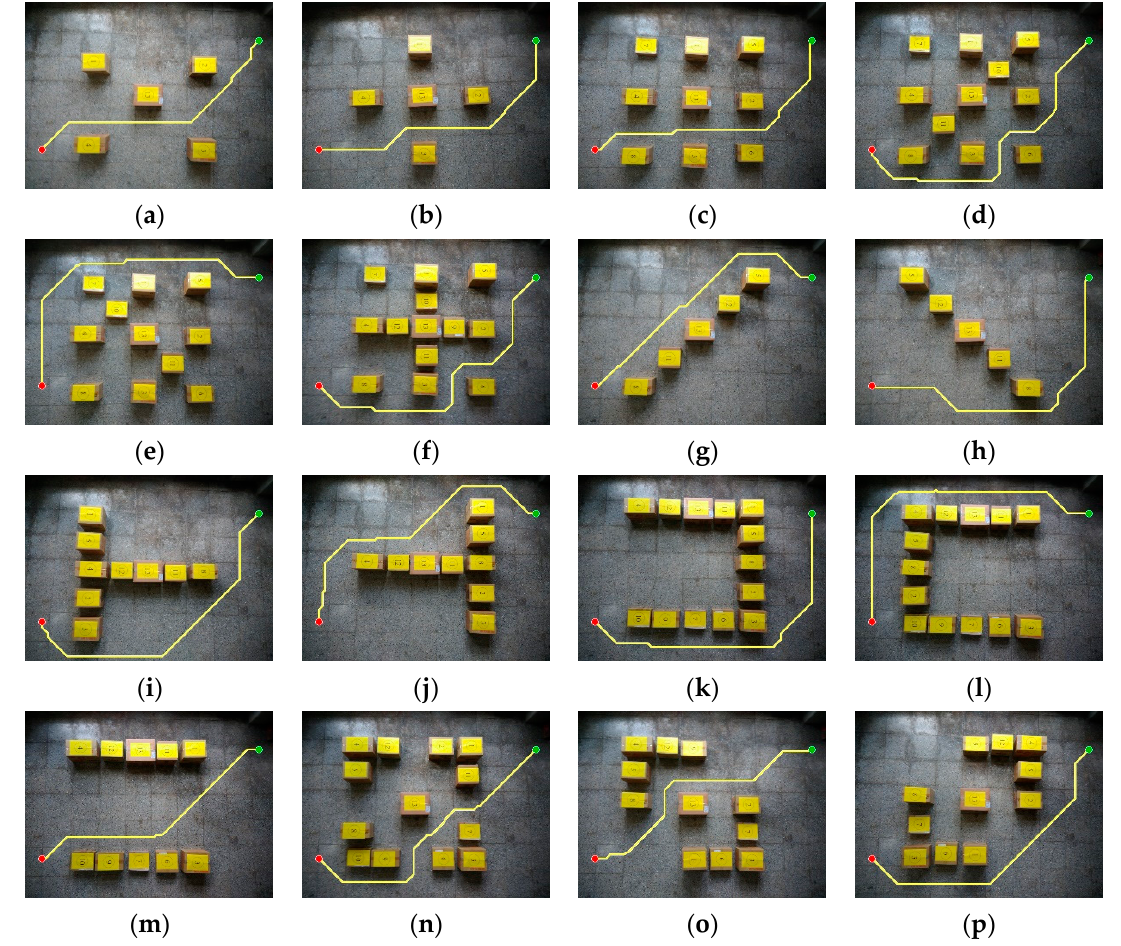
Figure 26. Planned paths shown in Experiment VII: ( a ) result #1; ( b ) result #2; ( c ) result #3; ( d ) result